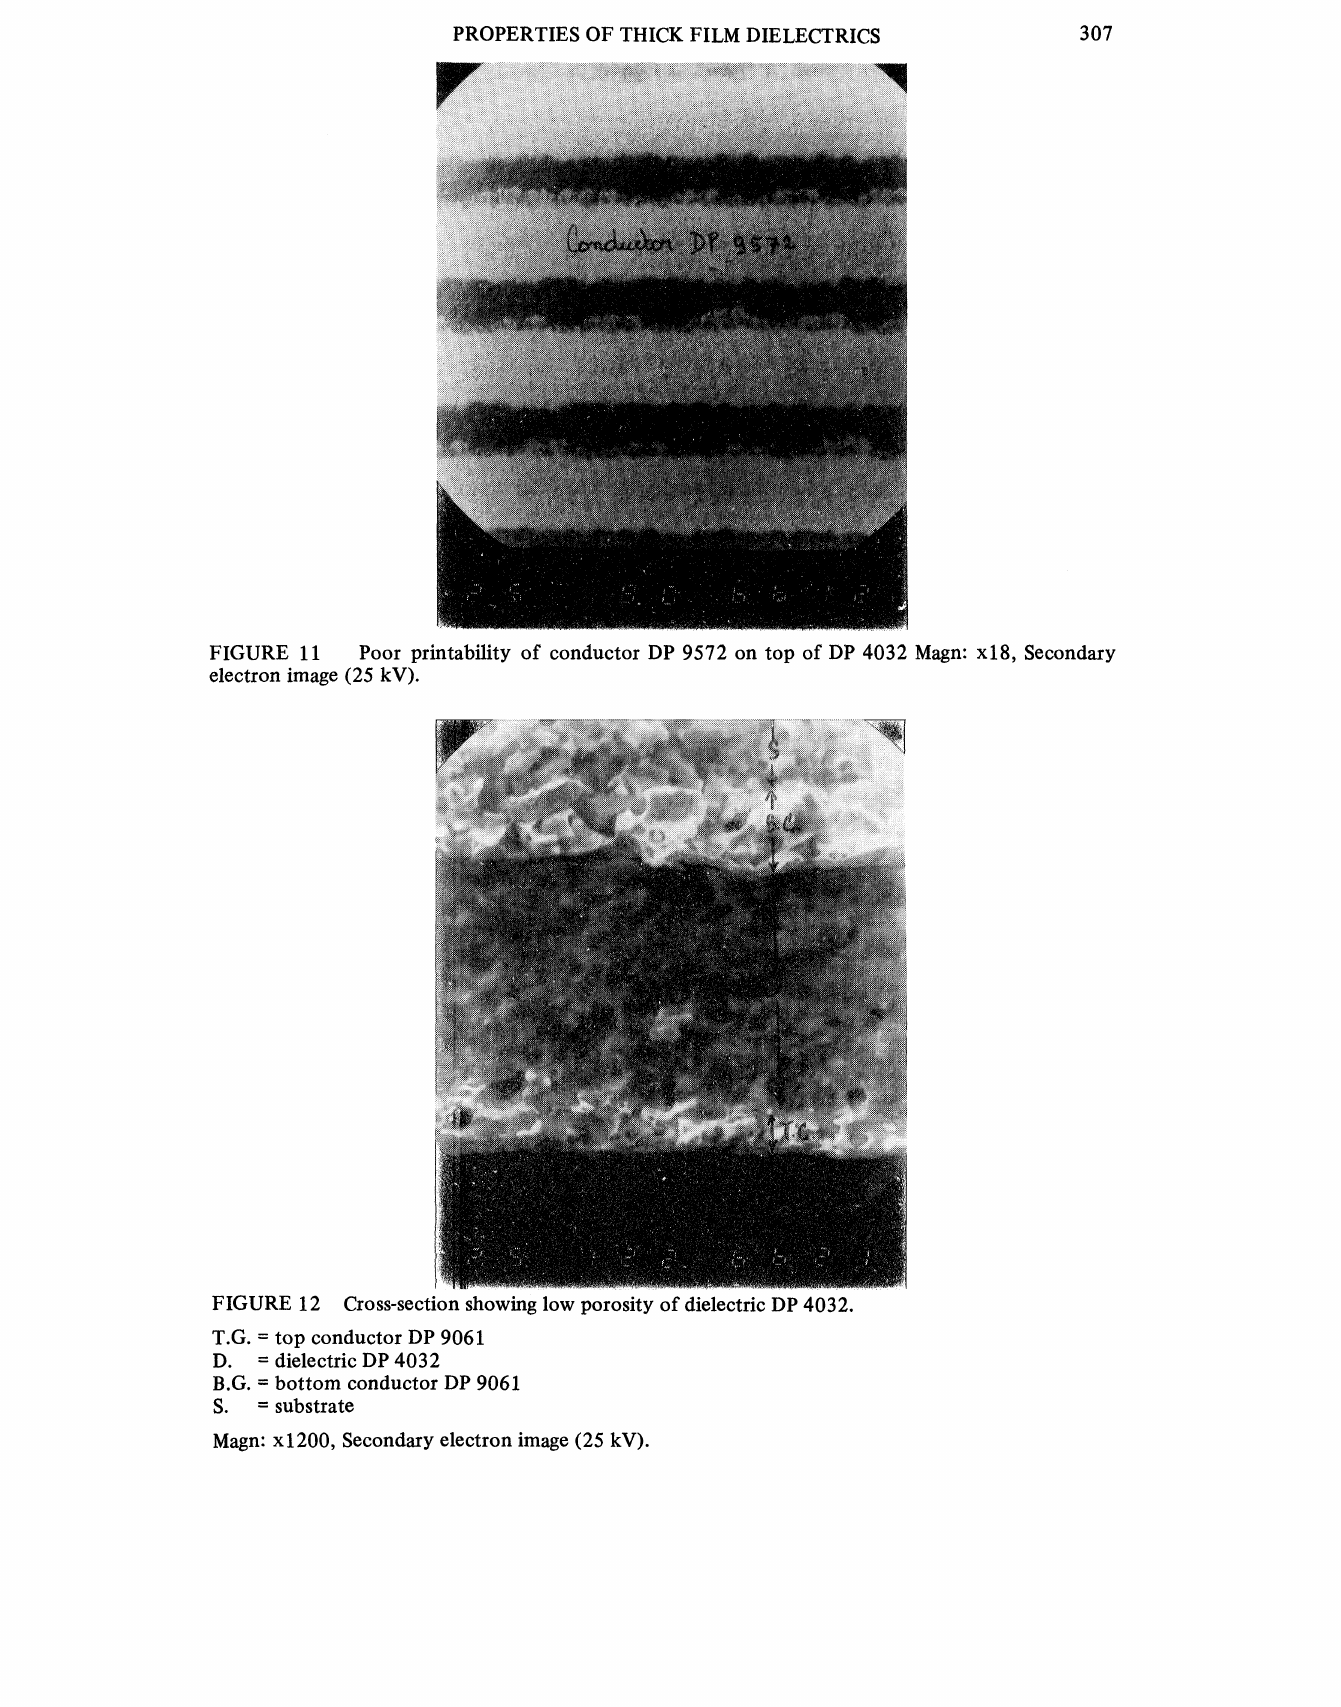
FIGURE 12 Cross-section showing low porosityof dielectric DP 4032. T.G. top conductor DP 9061 D. dielectric DP 4032 B.G. bottom conductor DP 9061 S. substrate Magn: x 1200, Secondary electron image (25